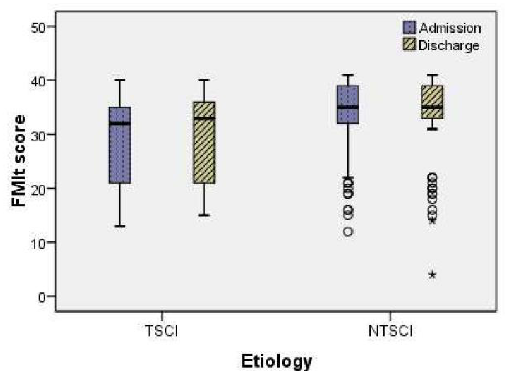
Figure 6. The distribution of FIMt scores across categories of etiology (T-SCI/NT-SCI).